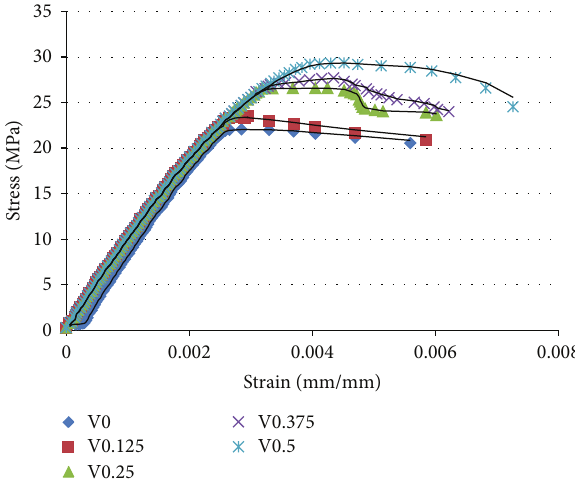
Figure 9: Typical stress-strain